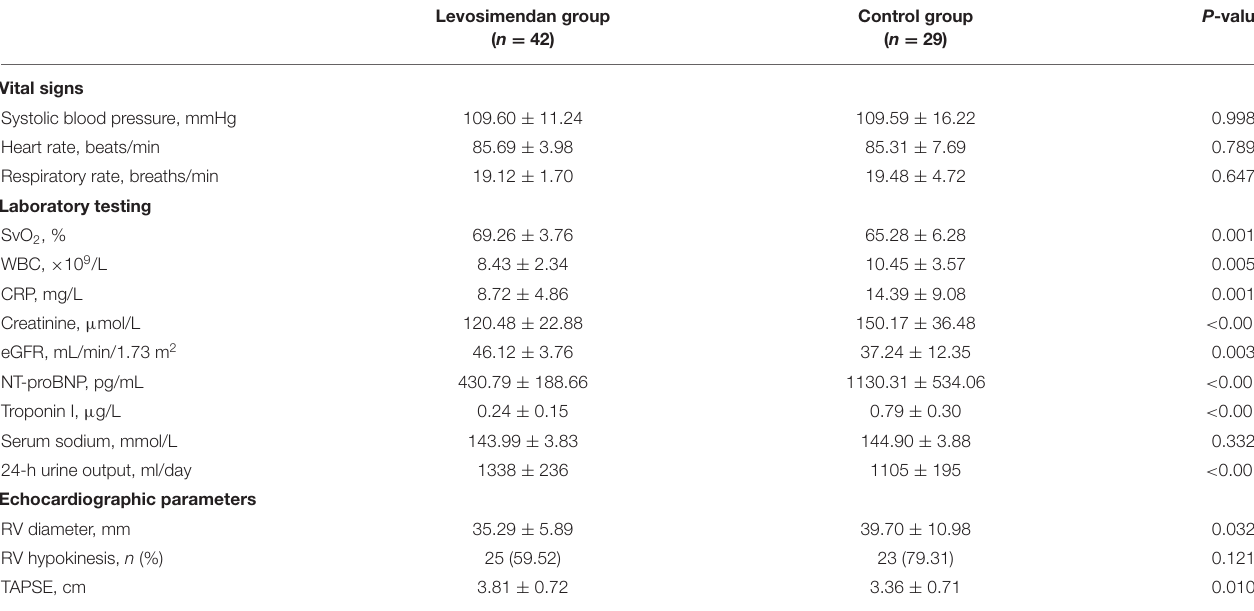
TABLE 2 | Comparison of patients’ characteristics at discharge.